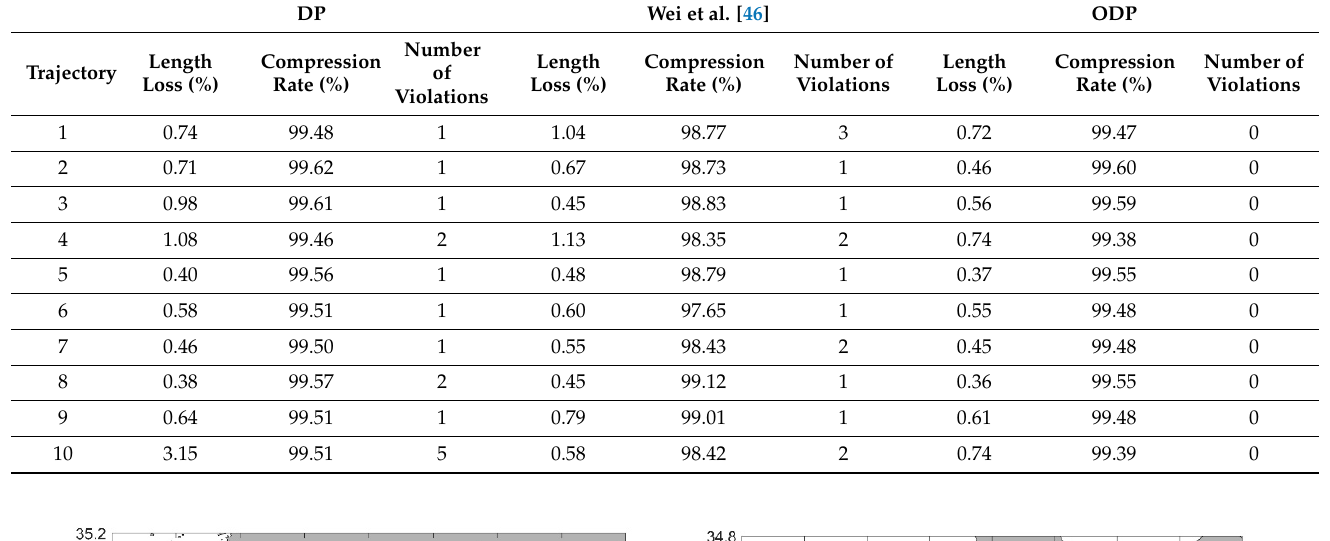
Table 4. Results of ODP and other algorithms.